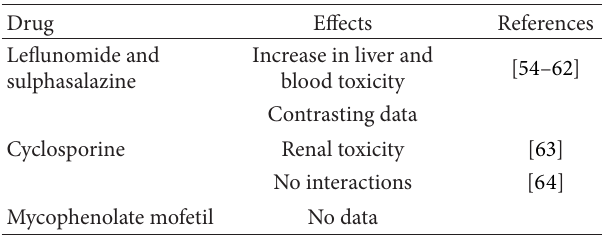
Table 4: MTX’s interaction with DMARDs and immunosuppres-